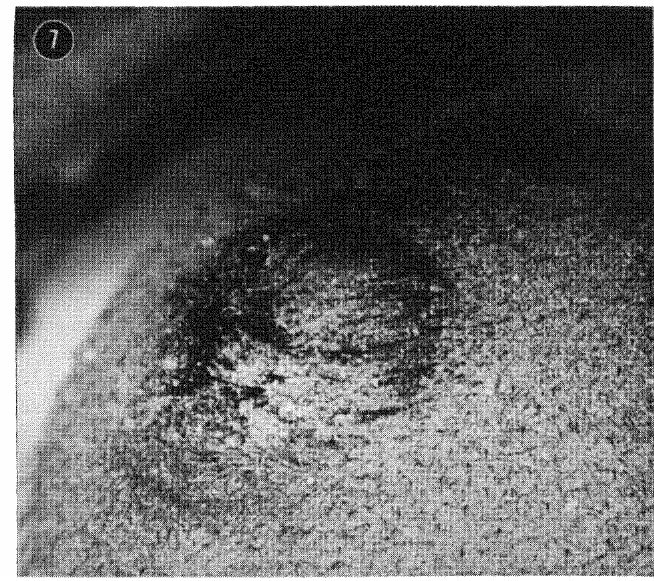
Fig. 7. Setae surrounding spinnerets that hold sand, seen from the side. At upper right is the genital groove.